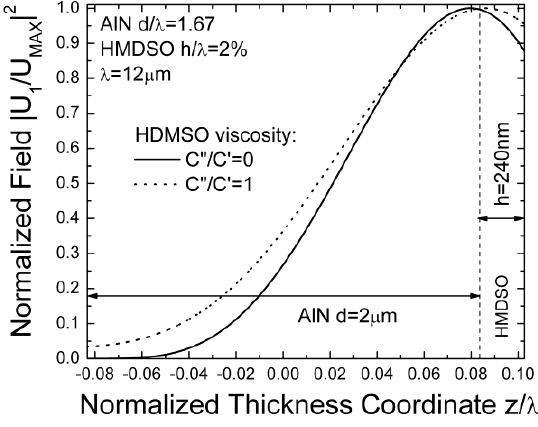
Figure 6. S0 Lamb wave confinement as function of the losses in the sensing